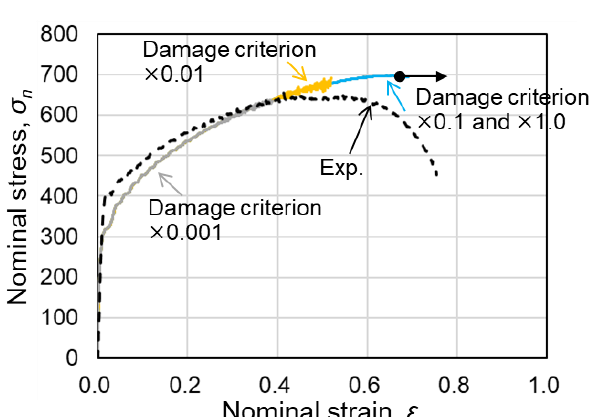
Fig. 5. Comparison between measured and simulated result using GTN model for SHB